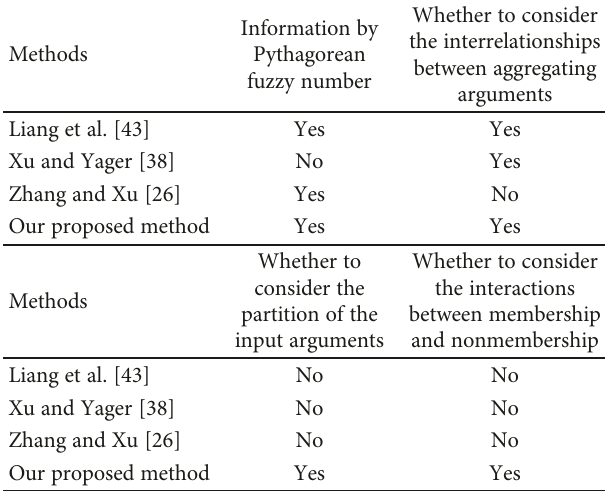
Table 11: The characteristic comparisons of di ff erent